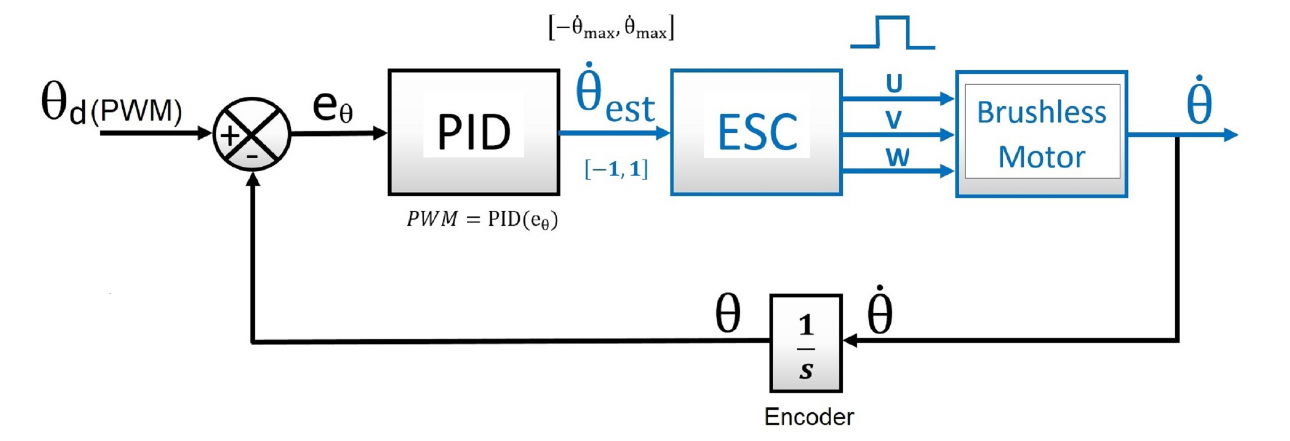
Figure 15. PID closed loop for angular position control in an active joint.